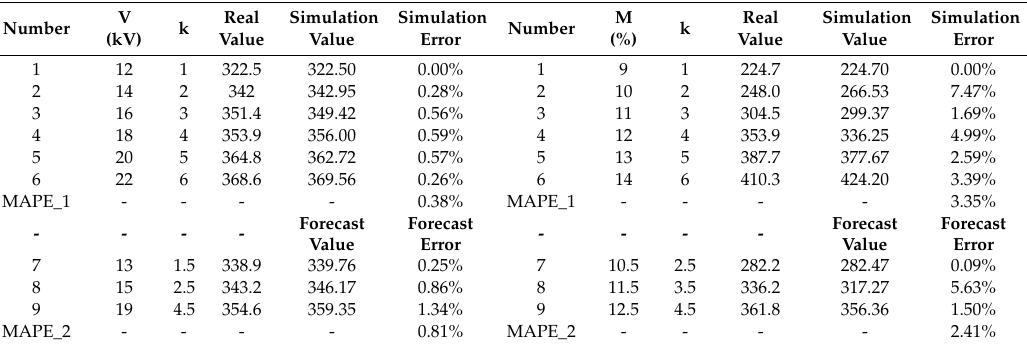
Table 2. Voltage (V) and Mass Fraction (M).